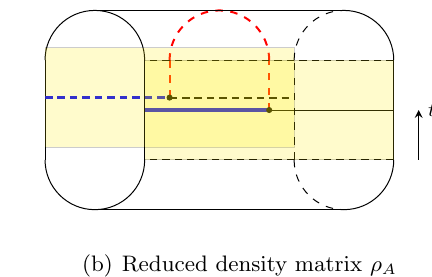
(b) Reduced density matrix (cid:26) A Figure 2 . (a) We picture the TFD state of the SYK chain model as a half tube. The two top edges correspond to the states in left and right Hilbert space. The subregion A = A L [ A R is de(cid:12)ned on both sides, and colored blue. The yellow shaded region corresponds to the real time evolution U ( t ), and the circular portion of the tube represents the initial imaginary time evolution of (1.3). (b) The density matrix (cid:26) A is then found by gluing two j TFD( t ) i states on A c and leaving A (blue) ‘open’. This perspective is useful in computing the partition function Z A;n , where the blue lines play the role of branch cuts. Each replicated fermion (cid:31) (cid:11) shifts its replica index to (cid:11) + 1 when it crosses the right branch cut line (the side closer to the reader) from below and shift to (cid:11) (cid:0) 1 when it crosses the left branch cut line from the above. We can further deform the two horizontal blue branch cuts to a single vertical dashed branch cut (shown in